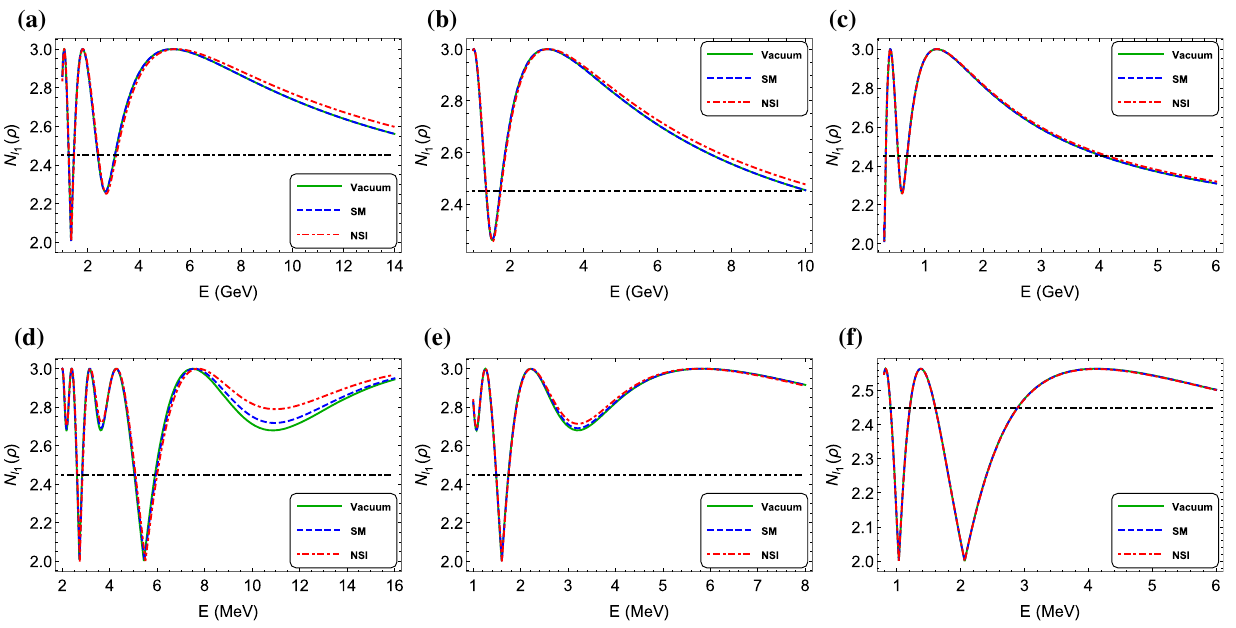
Fig. 2 Variation of NAQC parameter with energy ( E ) for the accel- erator and reactor experiments: a upper left: DUNE, L = 1300 km, E ≈ 1 − 14 GeV; b upper middle: MINOS, L = 735 km, E ≈ 1 − 10 GeV; c upper right: T2K, L = 295 km, E ≈ 0 − 6 GeV; d lower left: KamLAND, L = 180 km, E ≈ 1 − 16 MeV; and e lower middle: